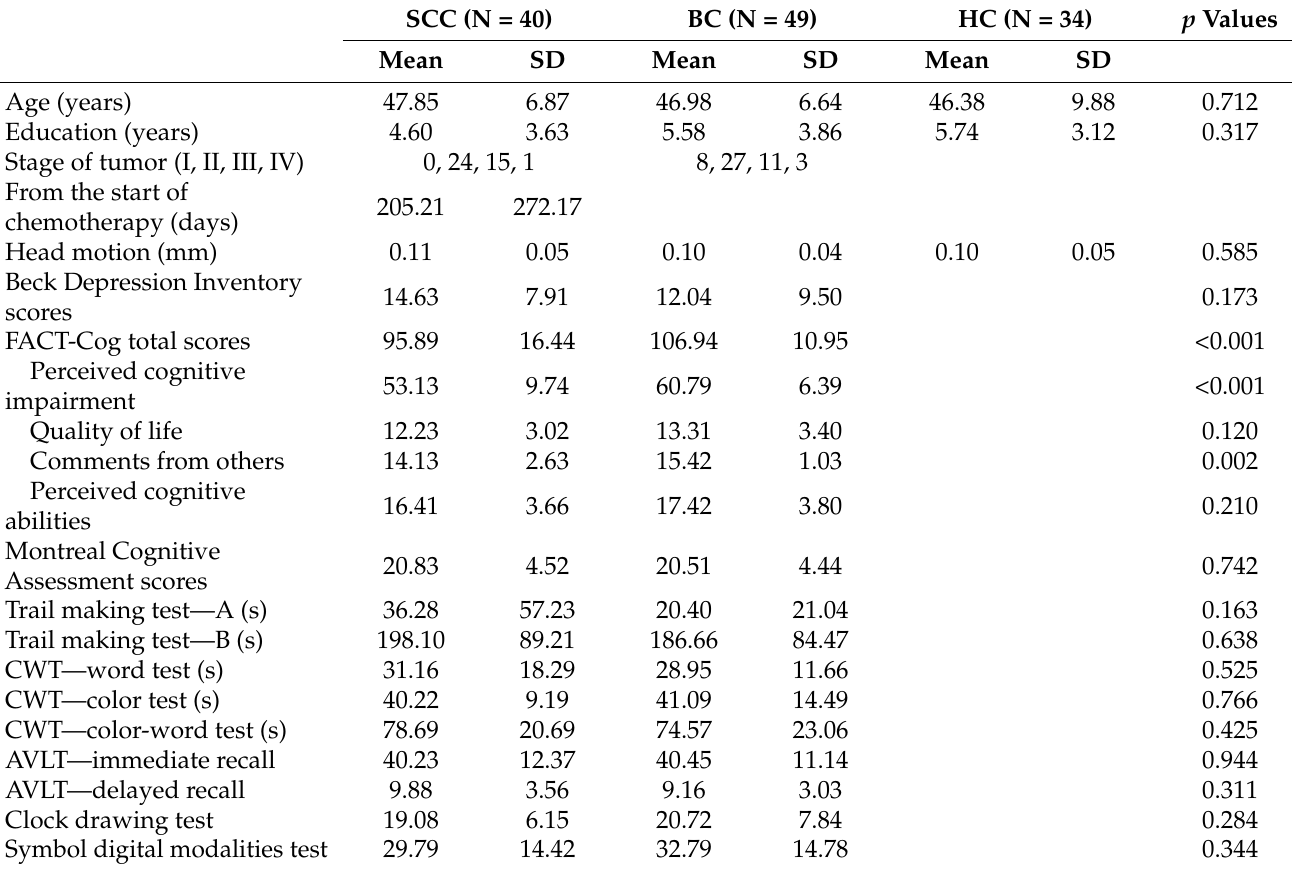
Table 1. Comparison of clinical characteristics and cognitive function among the three